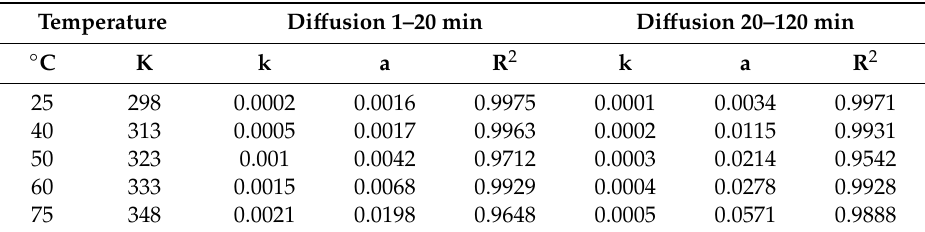
Table 3. Correlation coe ffi cients of di ff usion-controlled kinetics models at di ff erent temperatures for light REEs.